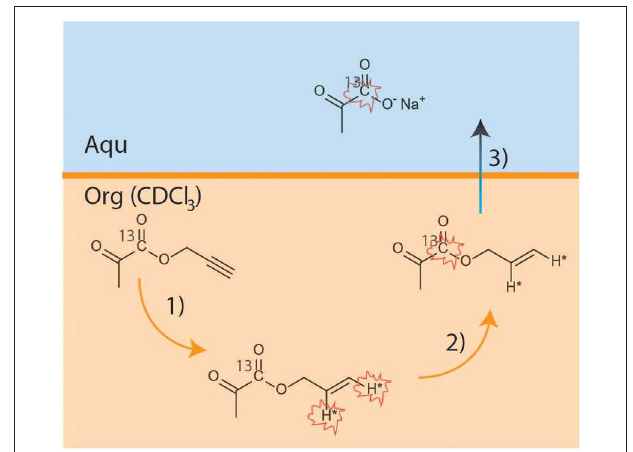
FIGURE 1 | Scheme reporting the key steps of the PHIP-SAH procedure: (1) hydrogenation using parahydrogen of propargyl-[1- 13 C] pyruvate; (2) polarization transfer to the 13 C carboxylate spin by means of magnetic field cycle (MFC); (3) hydrolysis and phase transfer of the Sodium salt from the organic to the water